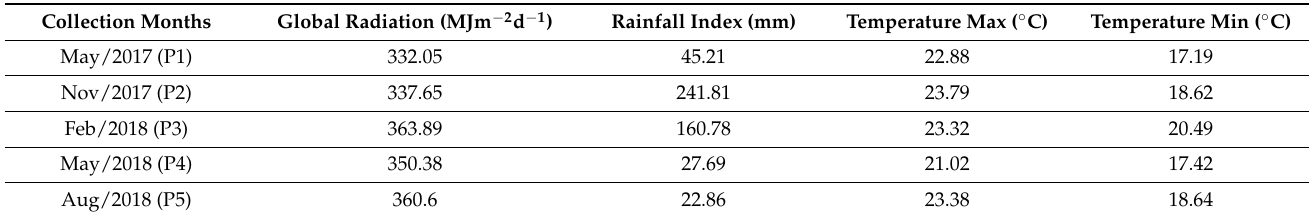
Table 5. Correlation index (r) from seasonal study of M. chamissois Naudin